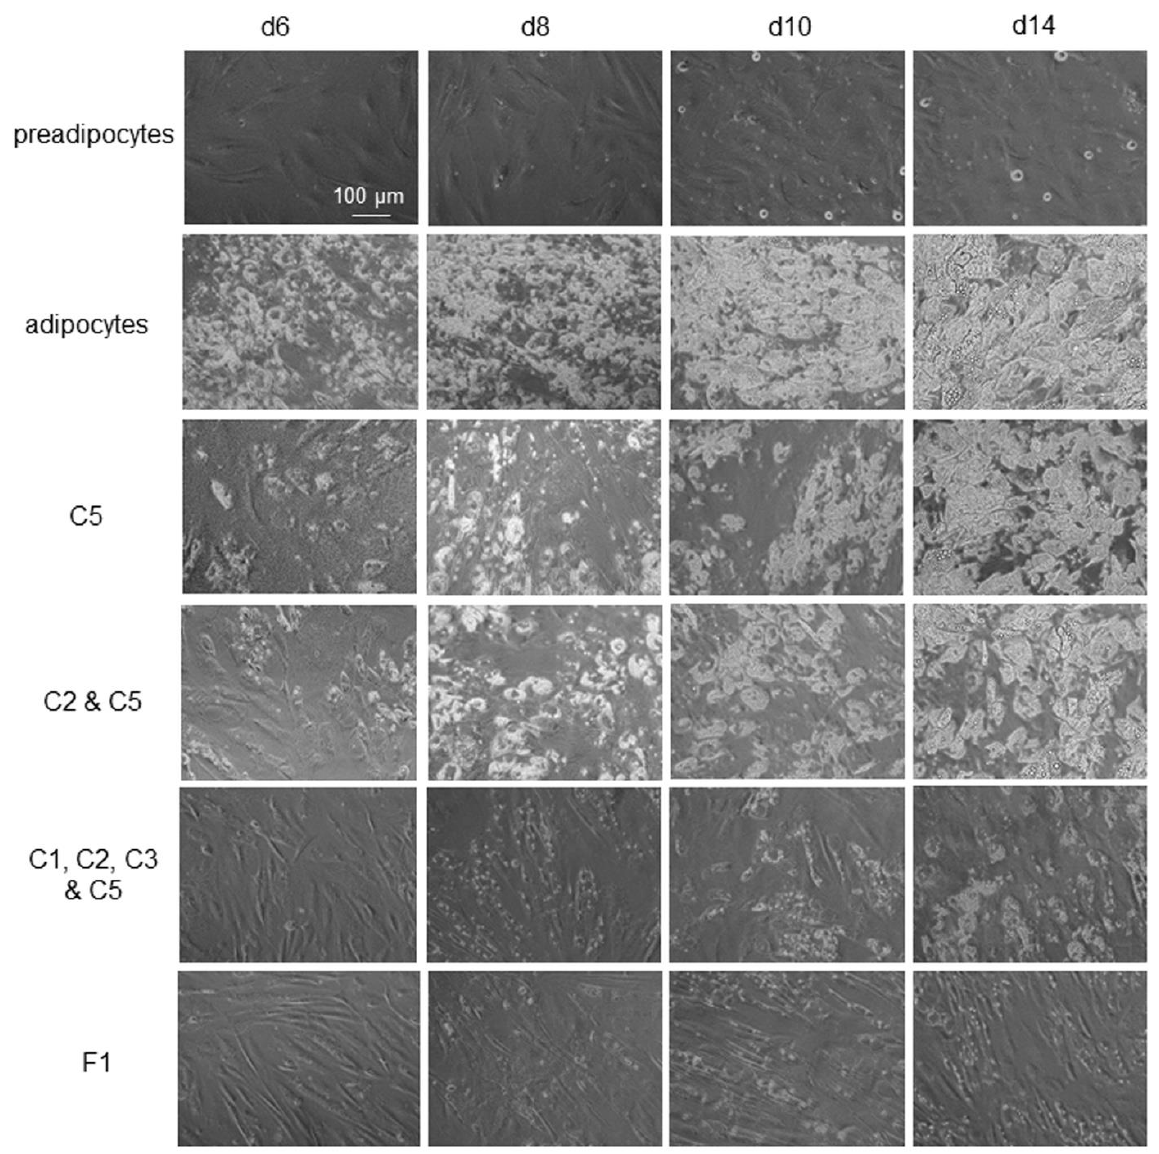
Figure 7. Potent and lasting inhibition of adipogenesis by F1 composition. First row: Undifferentiated preadipocytes in growth media. Second row: Differentiating preadipocytes or adipocytes. Third row: Differentiating preadipocytes in complete differentiation media supplemented with quercetin (C5). Fourth row: Differentiating preadipocytes in complete differentiation media supplemented with luteolin (C2) and quercetin (C5). Fifth row: Differentiating preadipocytes in complete differentiation media supplemented with berberine (C1), luteolin (C2), resveratrol (C3), and quercetin (C5). Sixth row: Differentiating preadipocytes in complete differentiation media supplemented with the F1 composition of phytonutrients. First column: d6 post-differentiation; second column: d8 post-differentiation; third column: d10 post-differentiation; fourth column: d14 post-differentiation. Cytoplasmic lipid droplets appeared as white particles under phase-contrast microscopy.